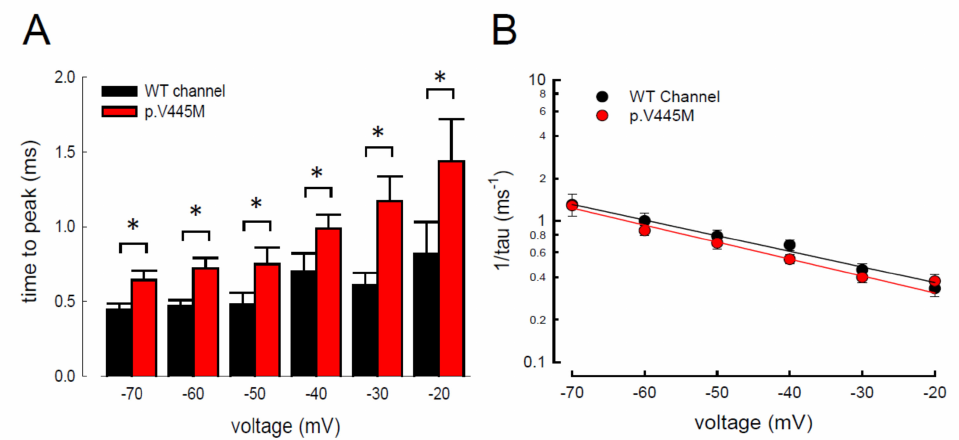
Figure 7. Slower time to peak of the resurgent Na + currents in the p.V445M mutant channel in the CHO-K1 cells ( A ) The time to the resurgent current peak was measured with the same protocol in Figure 4 ( n = 6). The time to the resurgent Na + current peak is significantly shortened in the WT than in the p.V445M mutant channel between − 20 and − 70 mV (*; p < 0.05). ( B ) The reciprocal of the time constants (1 / tau) for the decay phase of resurgent Na + currents was plotted against the voltage in semi-logarithmic scales for the WT and p.V445M mutant channels ( n = 8). The lines are linear regression fits of the form: 1 / tau (V) = 0.22 × exp( − 0.64V / 25) ms − 1 for the WT channel and 0.18 × exp( − 0.69V / 25) ms − 1 for the p.V445M mutant channel,